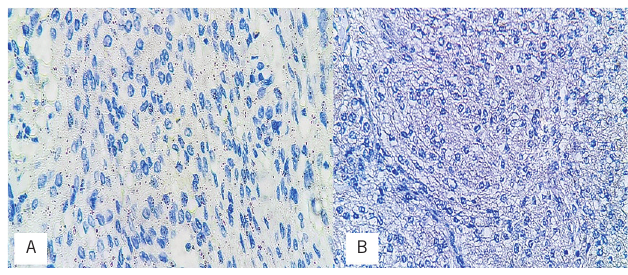
figure 1 – Negative immunohistochemical reactions with the two tested clones (20× magnification). Absence of complete circumferential or partial membrane staining in